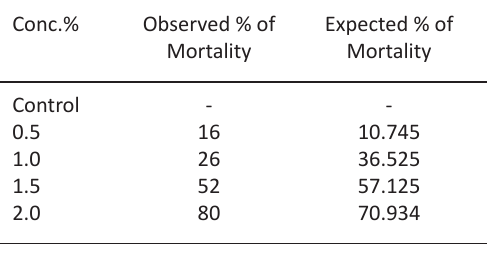
Table 1. Susceptibility of 2 nd instar larvae of M. domestica vicna to different concentration of Bacillus thruingiensis israelensis after 48 hrs from treatment Conc.% Observed % of Expected % of Mortality Mortality Control - - 0.5 16 10.745 1.0 26 36.525 1.5 52 57.125 2.0 80 70.934